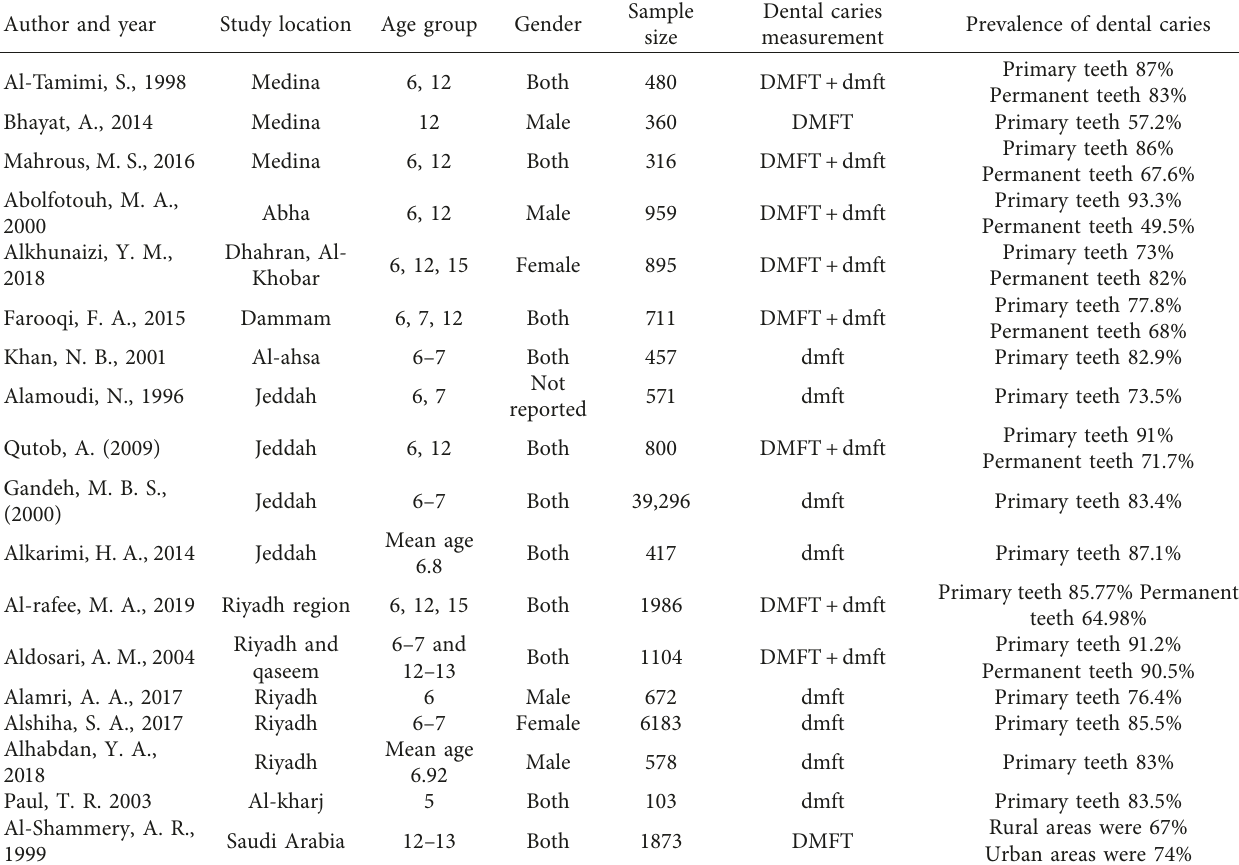
Table 1: Characteristics of included